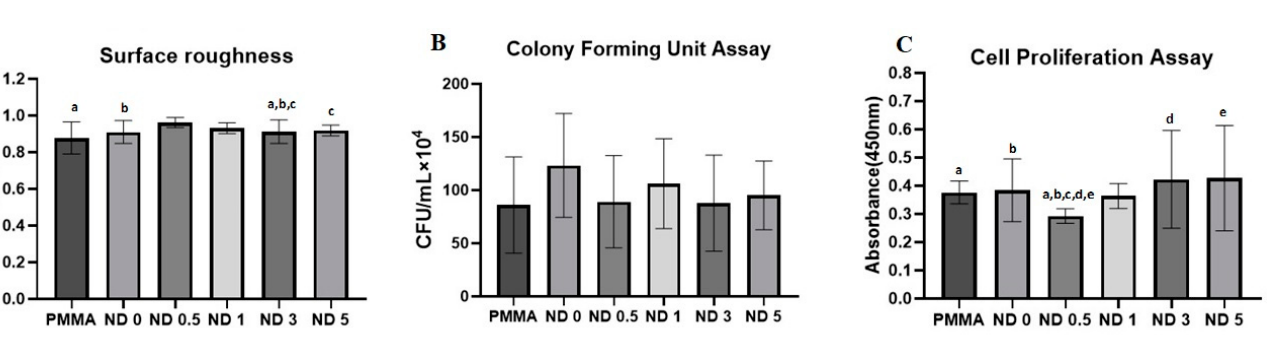
Figure 2. Results of surface roughness ( A ) and biofilm assay testing ( B , C ). Identical lower-case letters indicate significant differences in pairwise